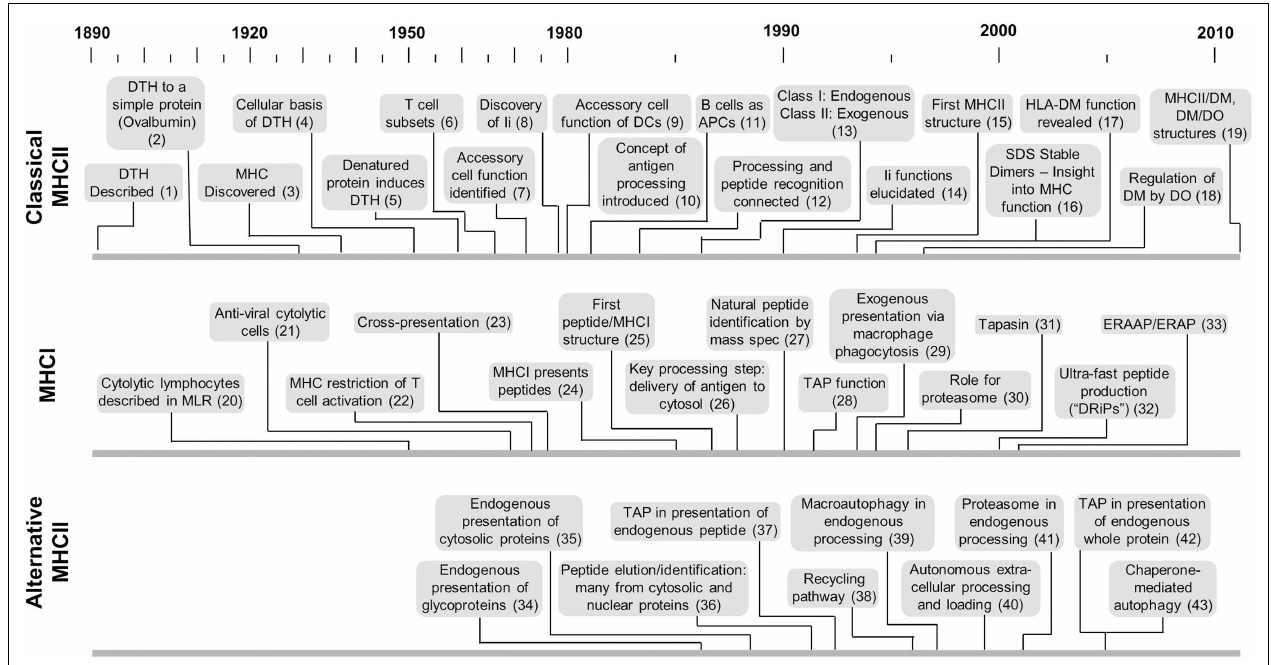
FIGURE 1 |Timelines of key developments with respect to MHCII-classical processing, MHCI processing, and MHCII-alternative processing. This is not intended to provide a comprehensive listing but more a sense of the genesis and evolution of each area with respect to the